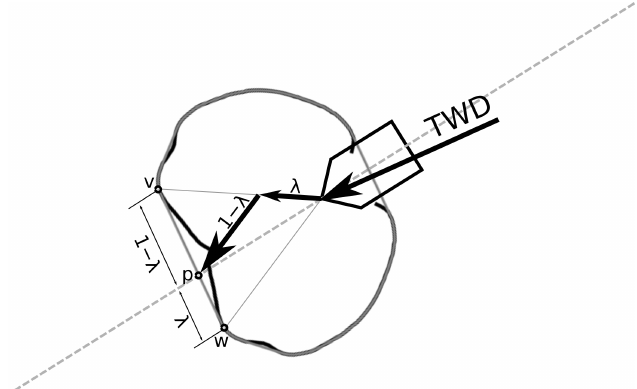
Figure 8. Diagram showing how to use the convex hull (gray) to obtain an overall better performance by tacks and